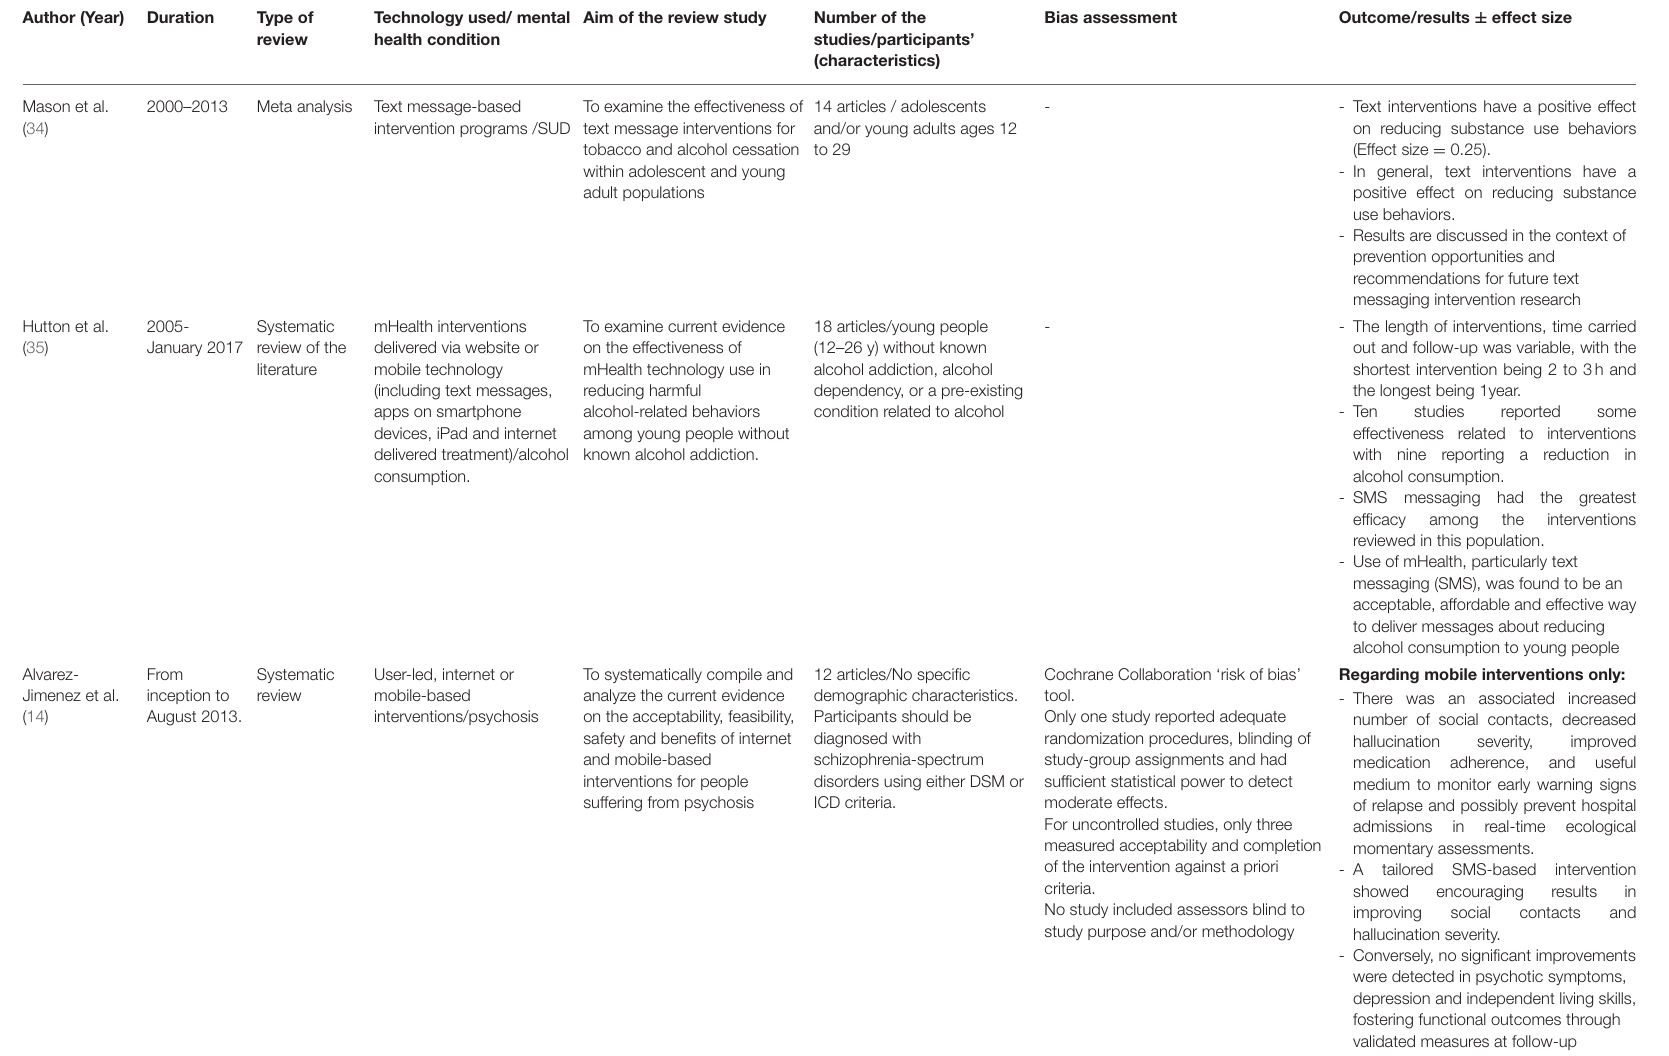
TABLE 1 | Summary of studies using Web-based interventions for the mental health disorders. Author (Year)